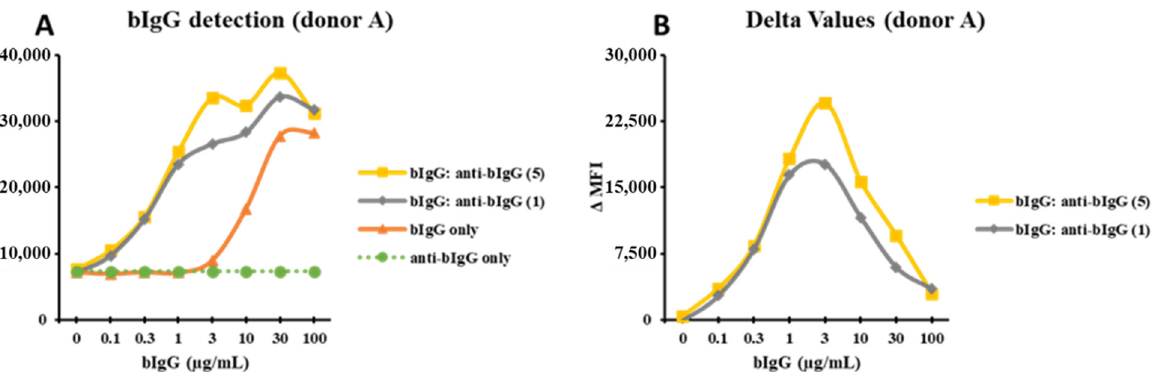
Figure 3. The curves drawn from MFI of the bIgG detection signal: the monocytes were exposed to bIgG only (0–100 µg/mL), α -bIgG (5 µg/mL) only, α -bIgG only (1 µg/mL), and the bIgG: α -bIgG ICs in one representative donor (donor A) ( A ). The delta MFI ( Δ MFI) was produced when the MFI of the bIgG only signal was deducted from the MFI of the bIgG: α -bIgG ICs signal ( B ).